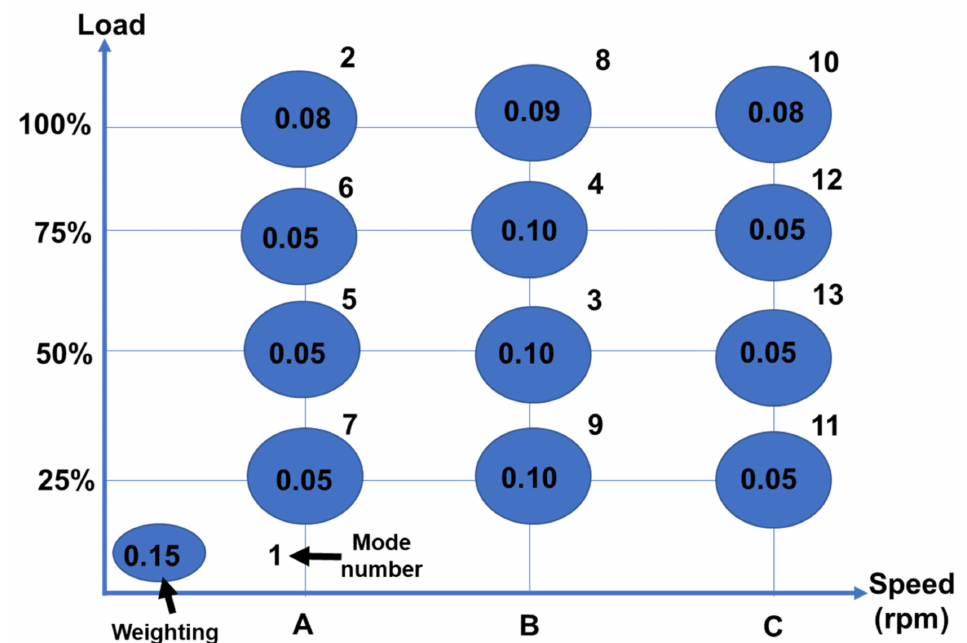
Figure 19. Engine speed and torque profiles when using the ESC test (Speed A: 1325 rpm, Speed B: 1750 rpm, Speed C: 2175 rpm, and Idle: 650 rpm), adapted from Wei et al. [45,67].